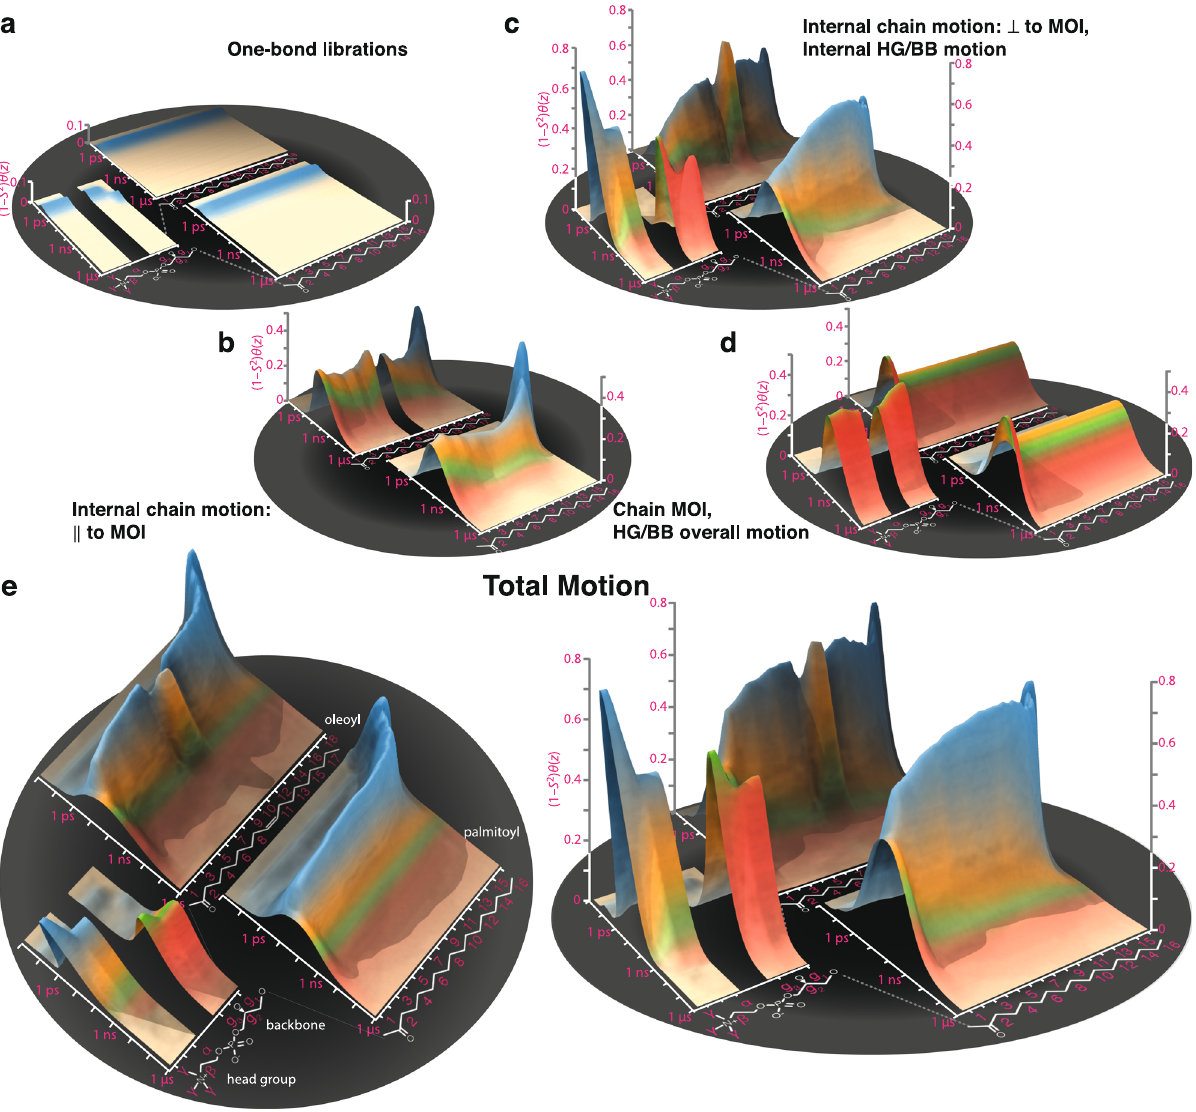
Fig. 6 Dynamic landscape of POPC membranes. a – d Fitted distributions of motion for the separated motion. Axes are the correlation time (left) and position (right), where each plot is broken up into parts (left: HG/BB; back: oleoyl; front: palmitoyl). The coloring corresponds to the experimental detector most sensitive to a given correlation time (blue: ρ 0 ; orange: ρ 1 ; green: ρ 2 ; red: ρ 3 ), where the intensity of the color is determined by the amplitude at the corresponding correlation time (fades to tan for small amplitudes). e The distribution of motion for the total motion, resulting from the product of correlation functions corresponding to the distributions in ( a – d ) (Eq. (4)). Details of fi tting and calculating the total distribution are given in Supplementary Note 4. Source data are provided as a Source Data